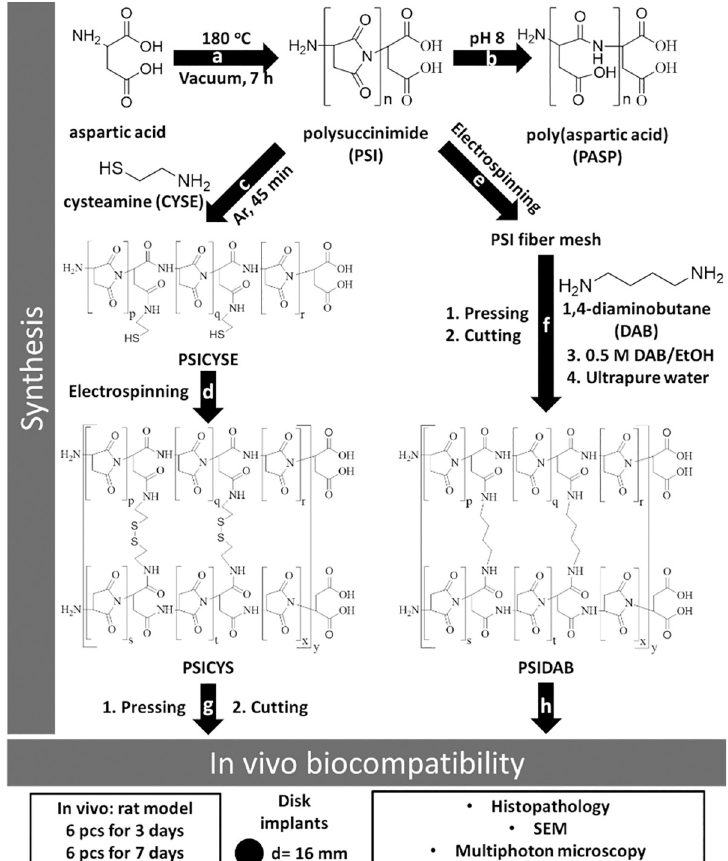
Fig 1. Schematic of the synthesis and investigation of materials subjected in this paper: synthesis of PSI (a); hydrolysis of PSI (b); modification of PSI with cysteamine (c); reactive electrospinning of cysteamine modified PSI (d); electrospinning of PSI (e); pressing, cutting and heterogenous crosslinking of polysuccinimide fibers with 1,4-diaminobuthane (f); pressing and cutting of PSICYS samples and implantation in a rat animal model (g); implantation of PSIDAB disks in a rat animal model